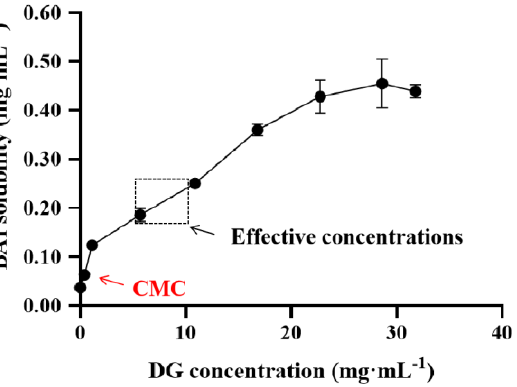
Figure 7. Phase-solubility diagram of the BAI-DG systems in water (the effective concentrations in the figure represent the concentration range of DG in animal experiments).